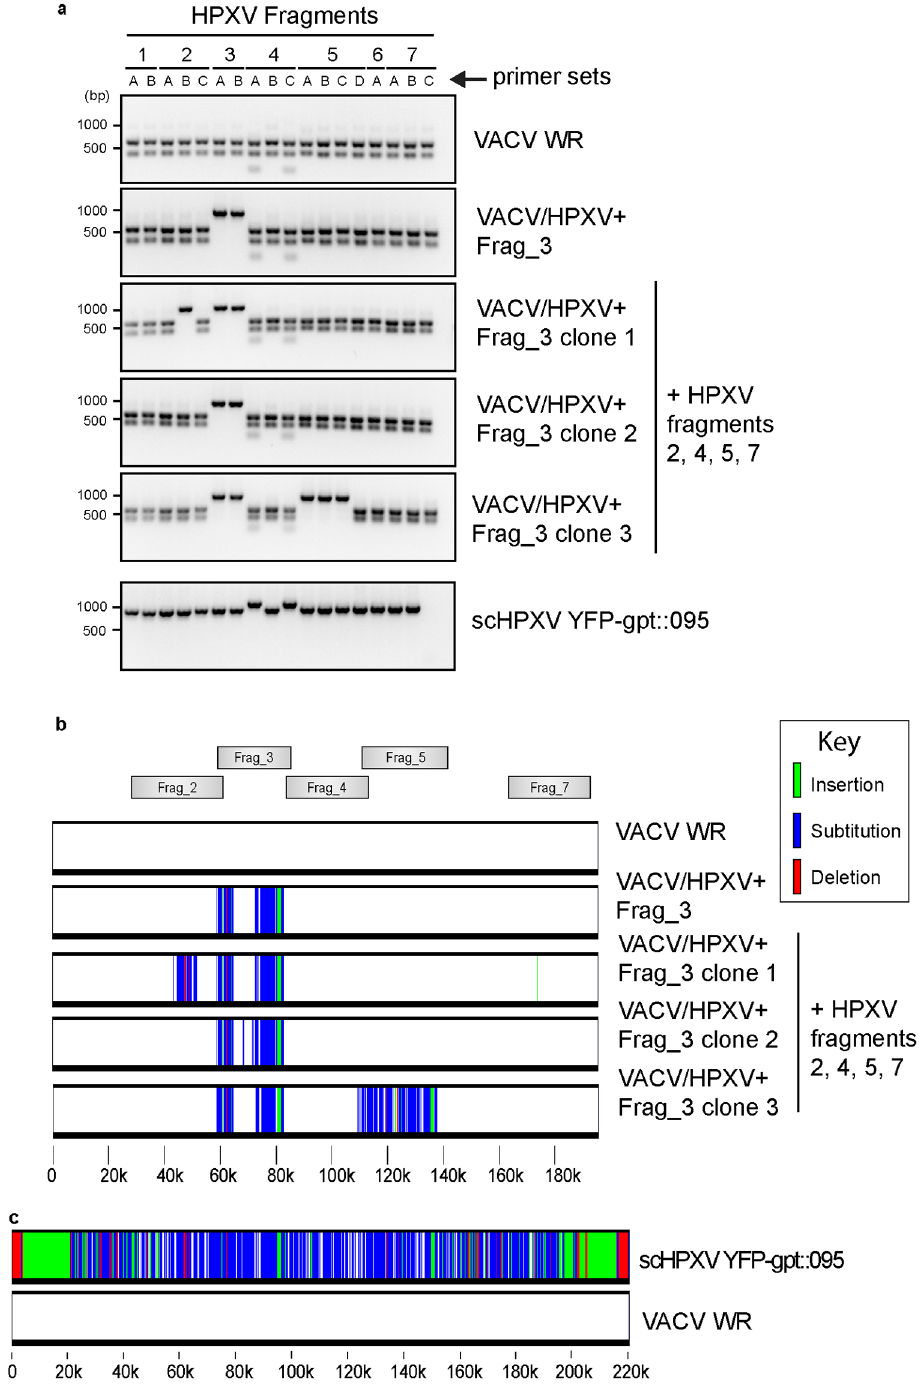
Fig 2. Characterization of VACV-HPXVhybrid viruses. a . A PCR-basedscreeningapproachwas used to identify hybrid and reactivatedviruses. PCR primers were designed to target both HPXV and VACV (S2 Table) and used to amplify DNA segmentsspanningthe Bsa I sites that were disrupted in the synthetic HPXV clones. FollowingPCR amplification, the products were digested with Bsa I to differentiateVACV sequences (which cut) from HPXV (which do not cut). The VACV/HPXV hybrids exhibita mix of Bsa I sensitive and resistant sites whereasa reactivatedscHPXV YFP-gpt::095 clone is fully Bsa I resistant. b .